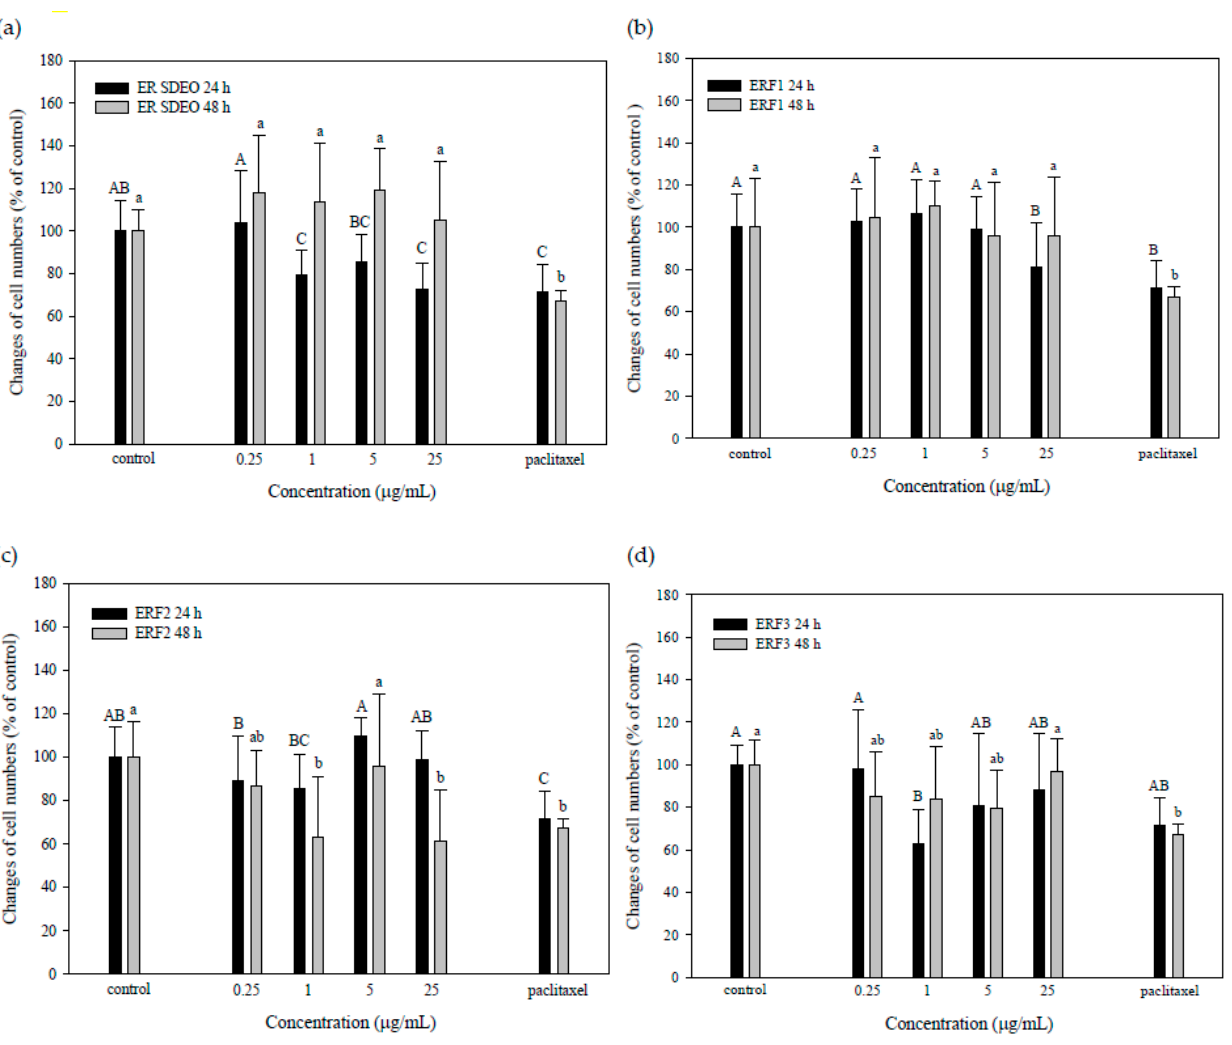
Figure 4. Effects of direct administrations with ER SDEO ( a ), ERF1 ( b ), ERF2 ( c ), and ERF3 ( d ) on the growth of PC-3 cells. Cells (1 × 10 6 cells/mL) were treated for 24 and 48 h, respectively. Values are means ± SD ( n = 6 biological determinations). Bars in the same plot at the same incubation time not sharing a common letter are significantly different ( p < 0.05) from each other analyzed by one-way ANOVA, followed by Duncan ′ s multiple range test. Paclitaxel at 2.5 μ M, a positive con- trol.